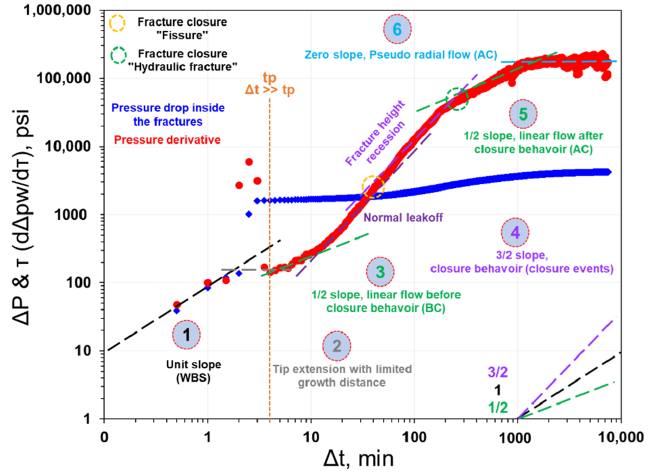
Figure 9. DFIT analysis and Bourdet pressure derivative plots for W2.